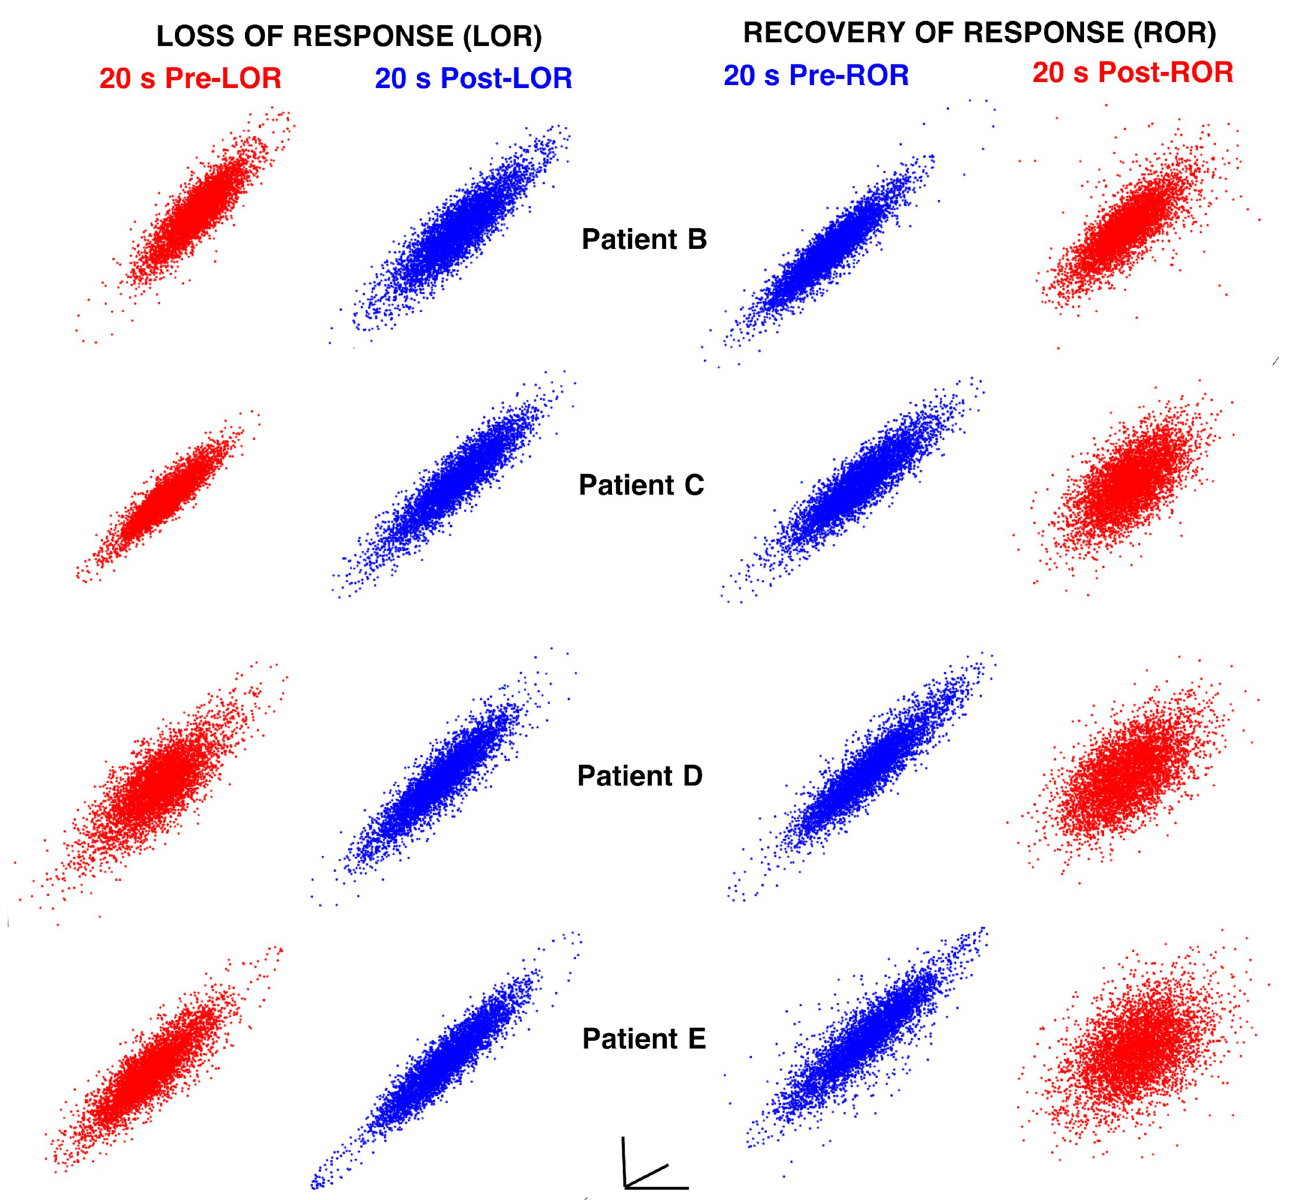
Fig 5. Attractor shape changes with loss and recovery of response. Examples of shape changes that occur before and after loss and recovery of response using 4 ms embedding delays. Although the attractors are three-dimensional, a two-dimensional projection is shown here for each attractor for each patient at the same viewing angle. During behavioral states when patients respond to verbal commands (red) attractors are more spherical and three-dimensional. During states when patients do not respond (blue), attractors are more ellipsoidal and